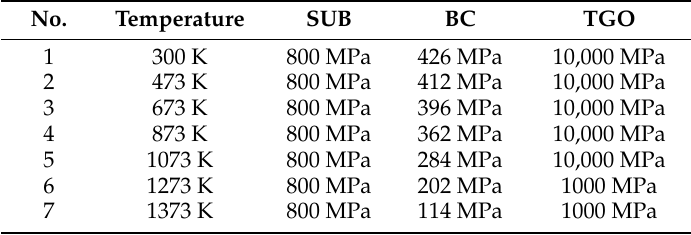
Table 2. The variations of yield strength with temperature for di ff erent layers